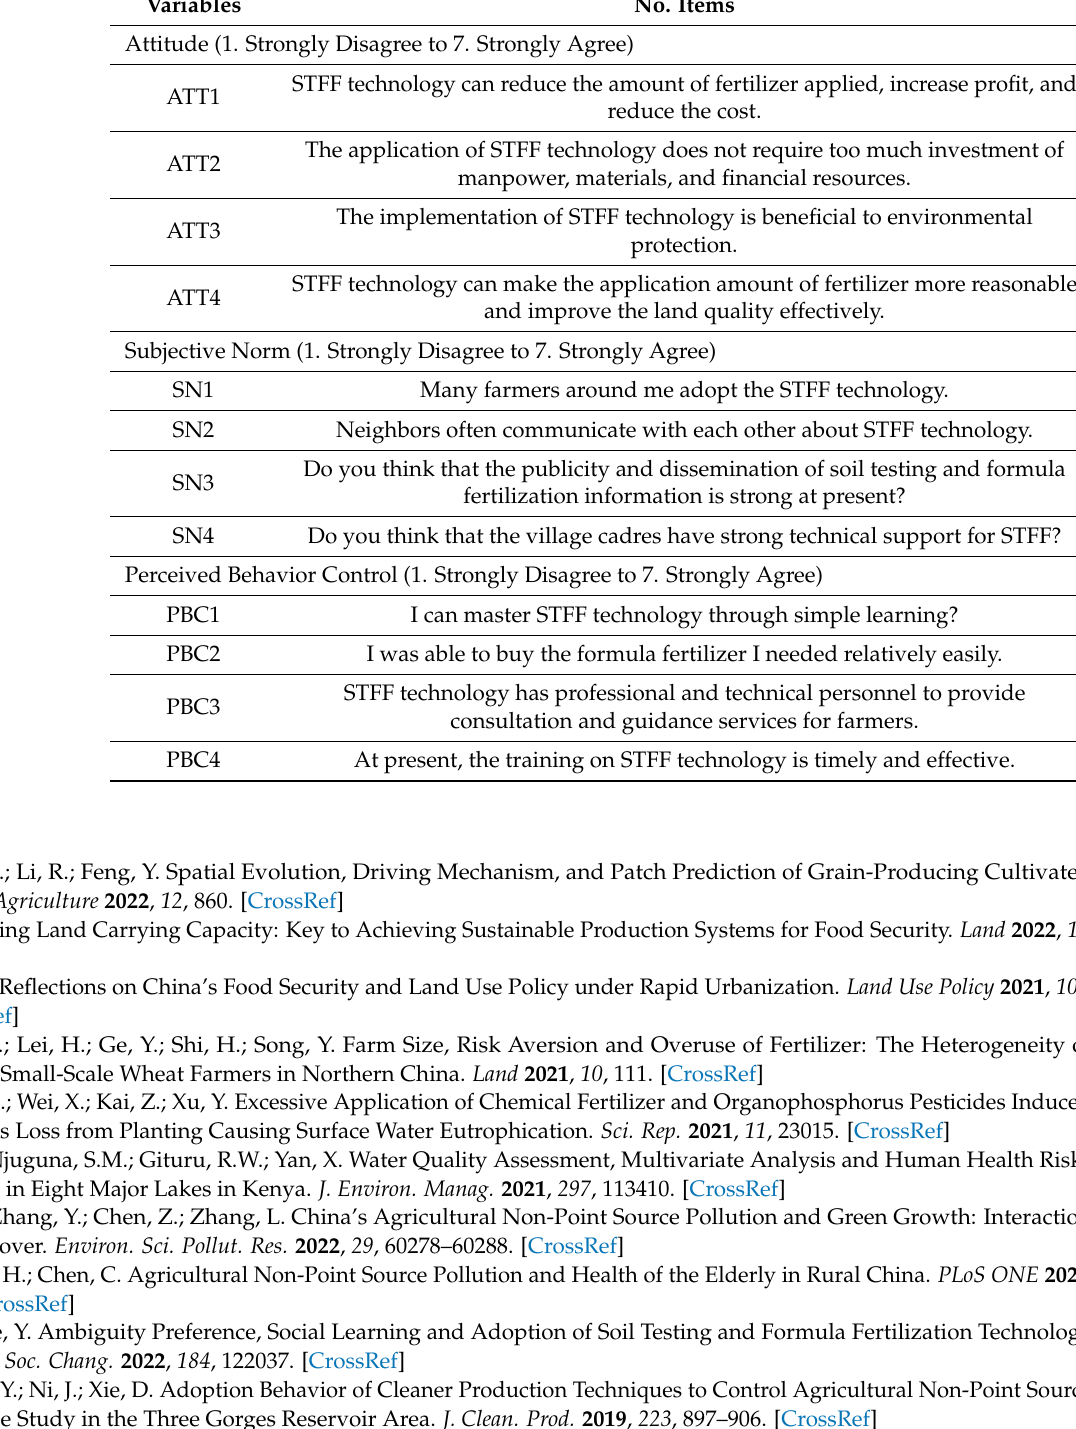
Table A1. Cont. Variables No.